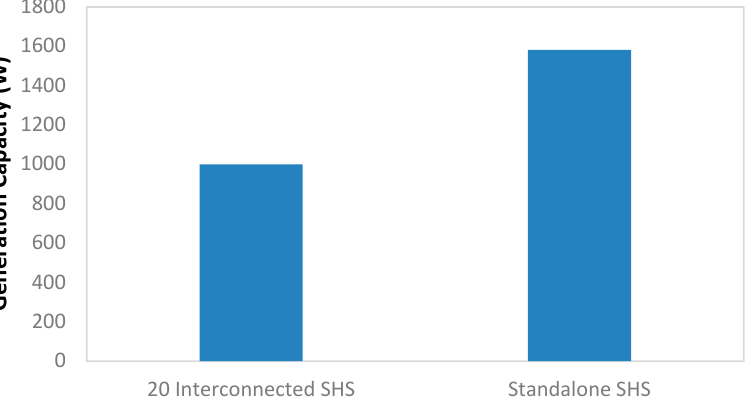
Figure 9. Generation required to supply fridge for 11 BBOXX customers while maintaining the reliability of power supply at 95%.